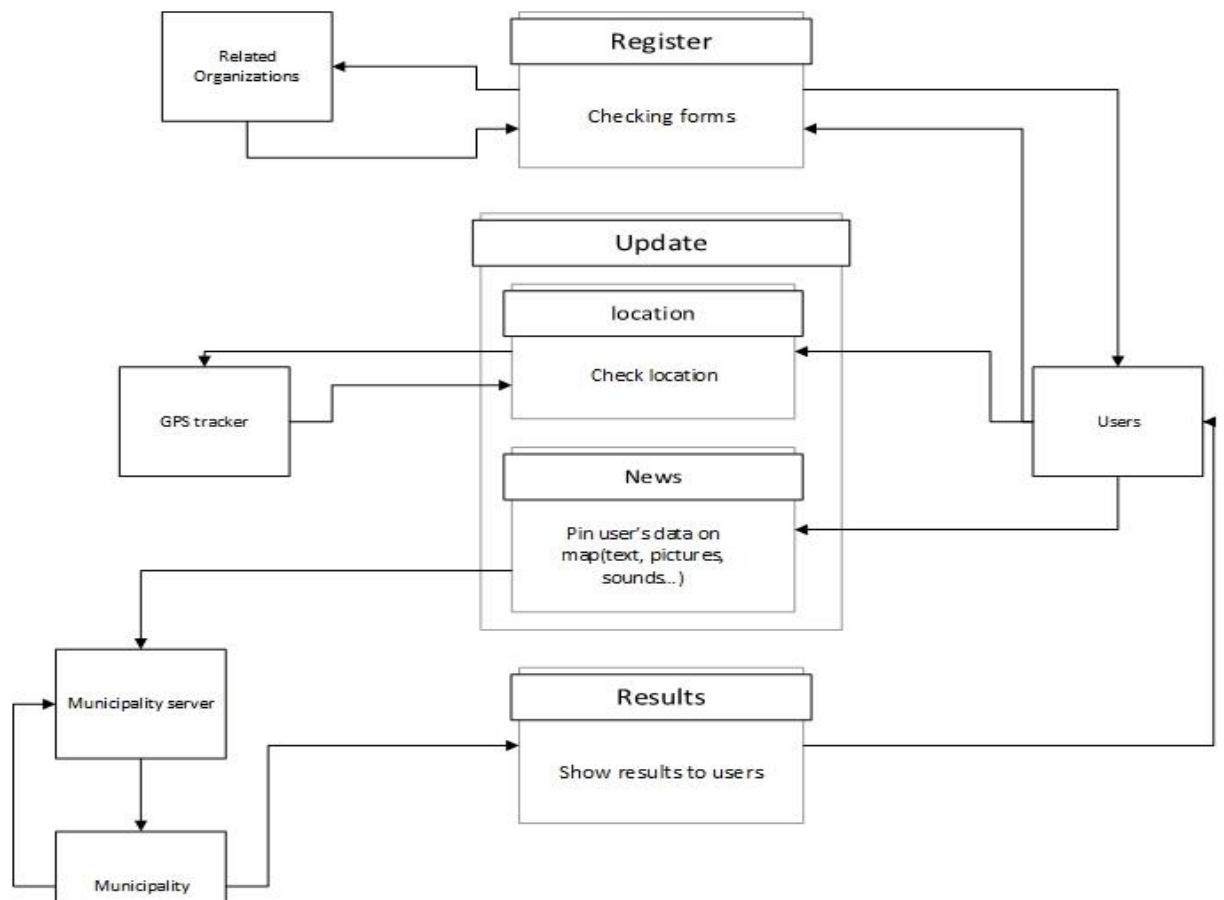
Figure 1: Conceptual framework for F-VGI based environmental